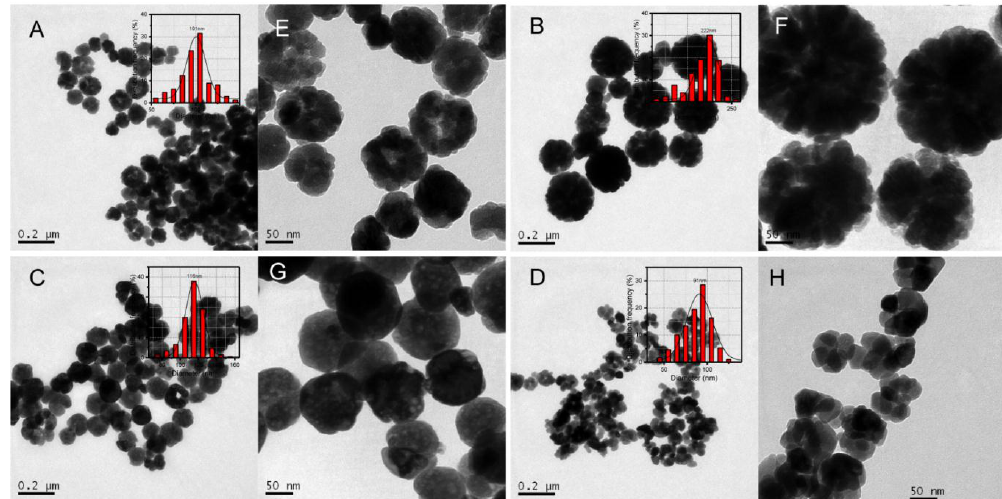
4 of 14 Figure 1. SEM images of Fe 3 O 4 with different molar quantity of FeCl 3 ·6H 2 O, ( A ) 0.4 mmol; ( B ) 5 mmol; ( C ) 10 mmol; ( D ) 20 mmol. The TEM images and corresponding particle size distribution of the as-prepared Fe 3 O 4 NPs are presented in Figure 2. The S1 showed spherical morphology with average particle size of 101 nm (Figure 2A,E). But the size distribution is wide, and the hollow structure is not obvious. After